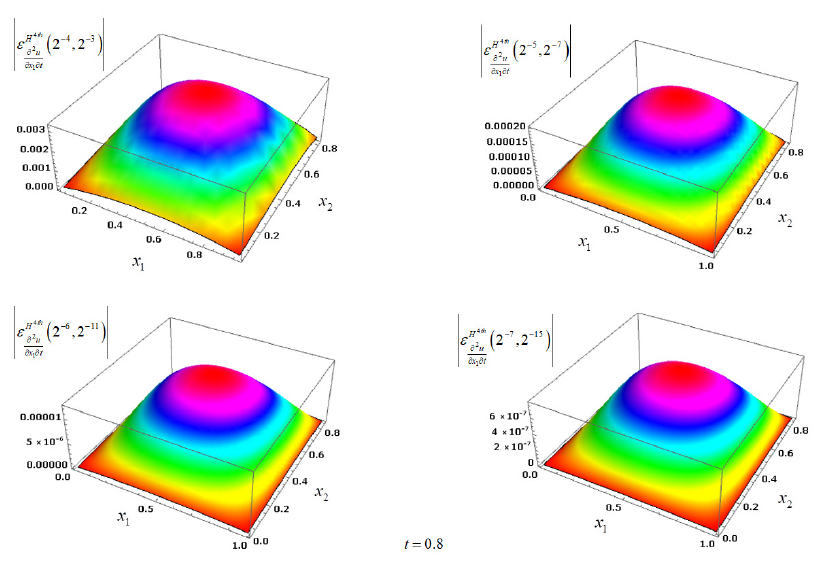
(cid:16) (cid:17) ∂ 2 u for ∂ x 1 ∂ t